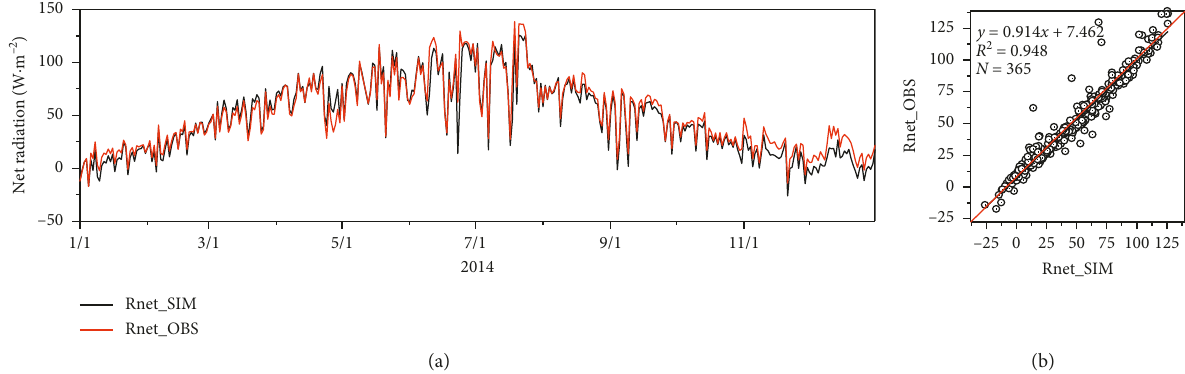
Figure 11: Contrast curve (a) and scatter plot (b) of the simulated (black) and observed (red) net radiation ( R 2014.